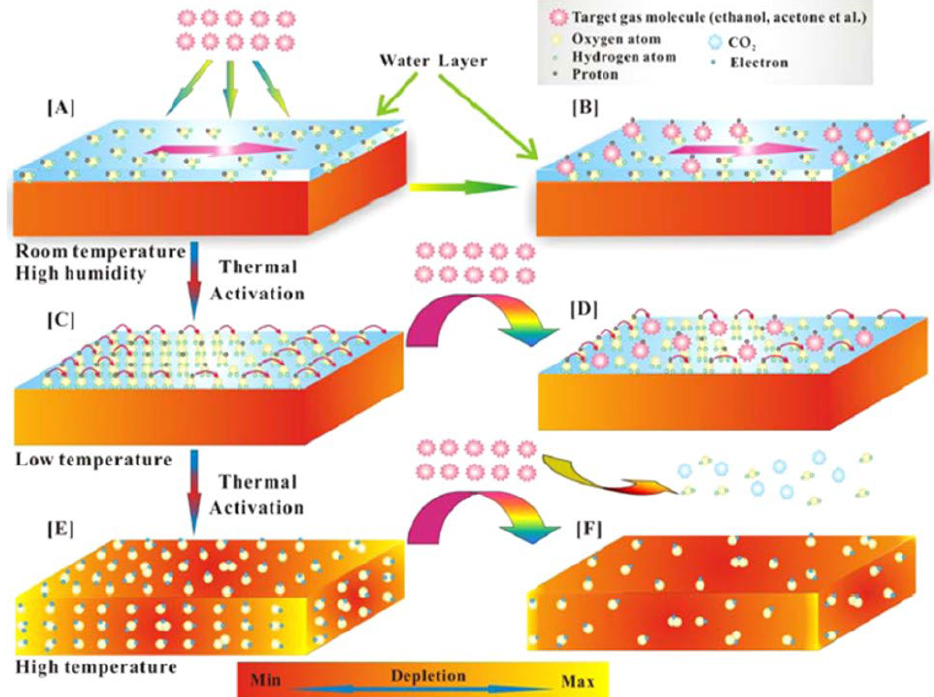
Figure 11. Schematic diagram showing the sensing mechanism of sensors at different working conditions: ( A , B ) high temperature and high humidity, ( C , D ) low temperature (a slight thermal shock to the sensor) and ( E , F ) high temperature. (Reprinted with permission from [75]. Copyright 2015, American Chemical Society, Washington, DC, USA).